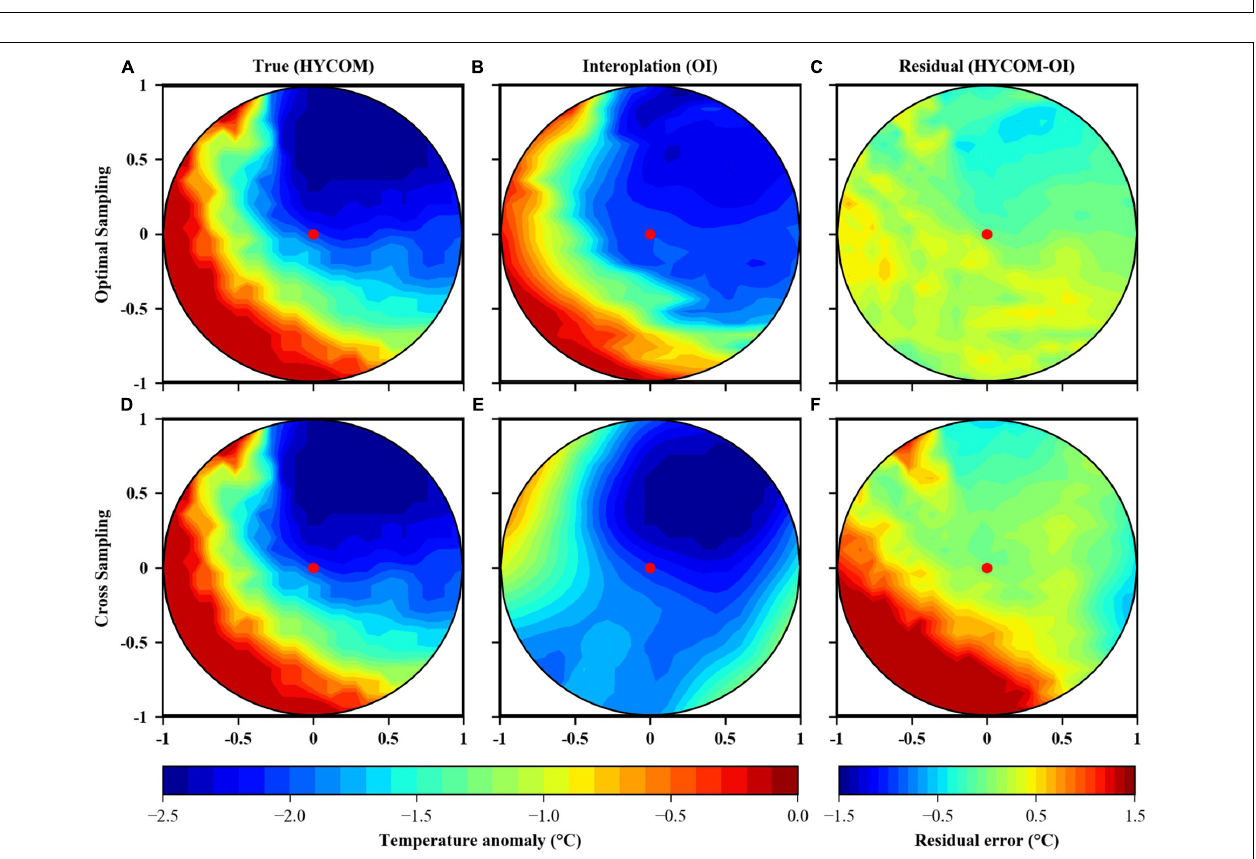
FIGURE 11 | Comparison of temperature anomaly inside the target eddy on July 24, 2015. The first row is the synthetic results of the “Optimal Sampling,” the second row is the synthetic results of the “Cross Sampling”. (A,D) Are the true value of HYCOM data, (B,E) are the estimated value after data interpolation, (C,F) are the residual errors between the estimated value and the true